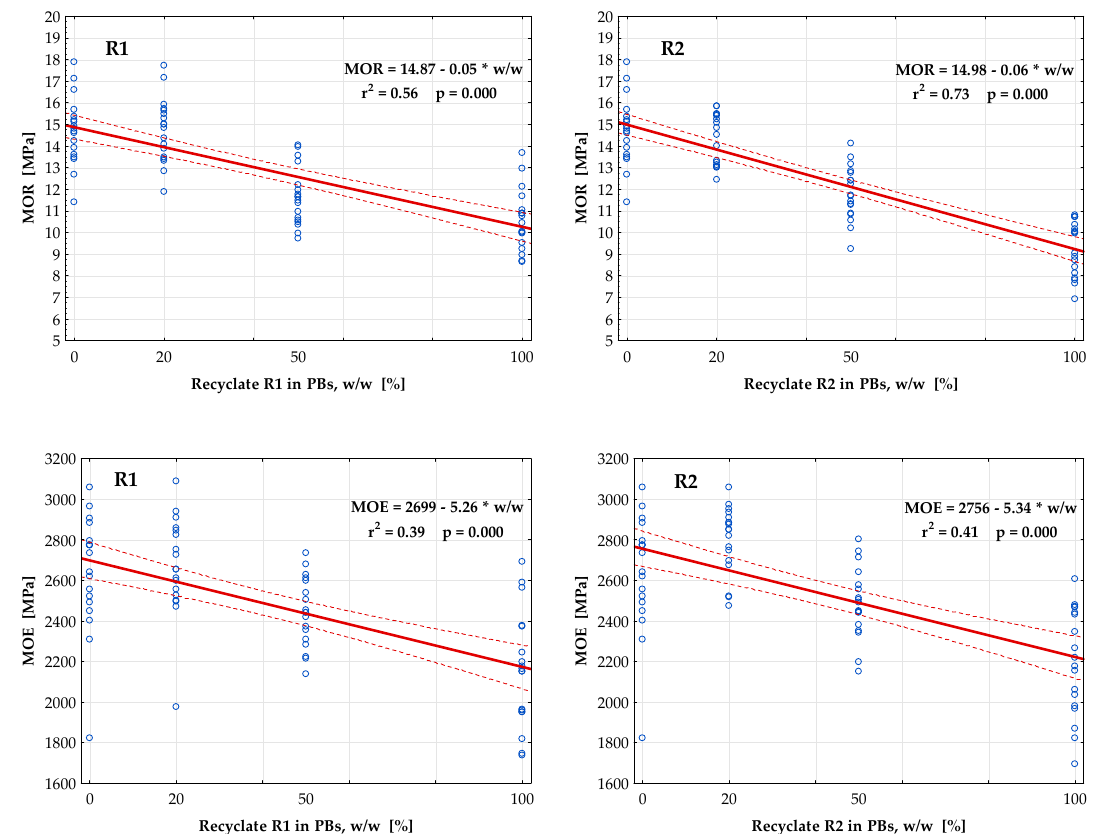
Figure 6. Modulus of rupture (MOR) and modulus of elasticity (MOE) of PBs containing different types (R1 or R2) and amounts of wood recyclates.